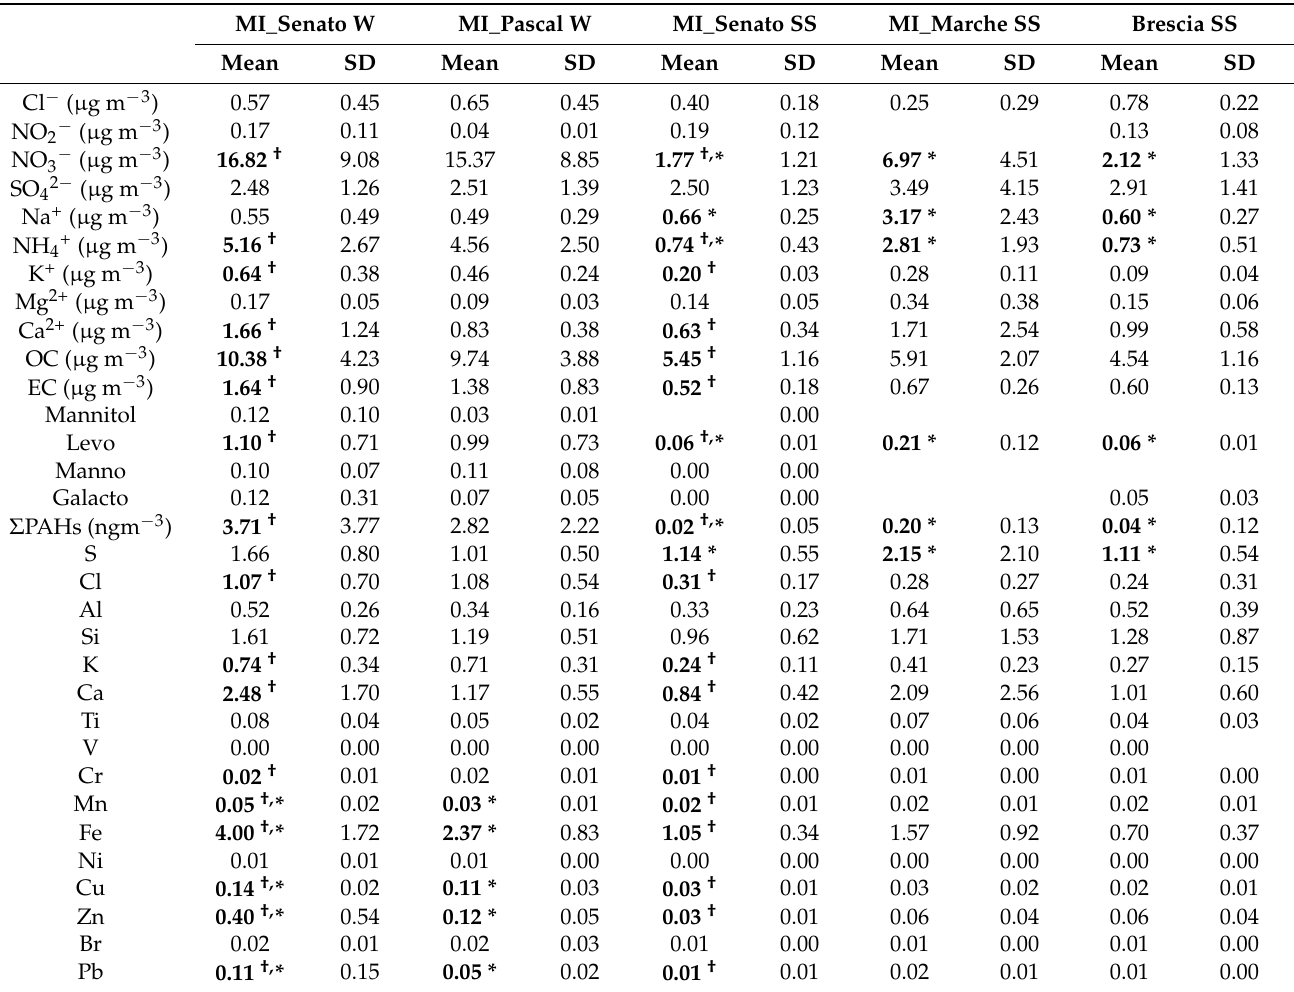
Table 4. Concentration values of the chemical components of PM 10 filters collected in each monitoring campaign: means and standard deviation data. Units: all analytes ( µ g m − 3 ); Σ PAHs (ng m − 3